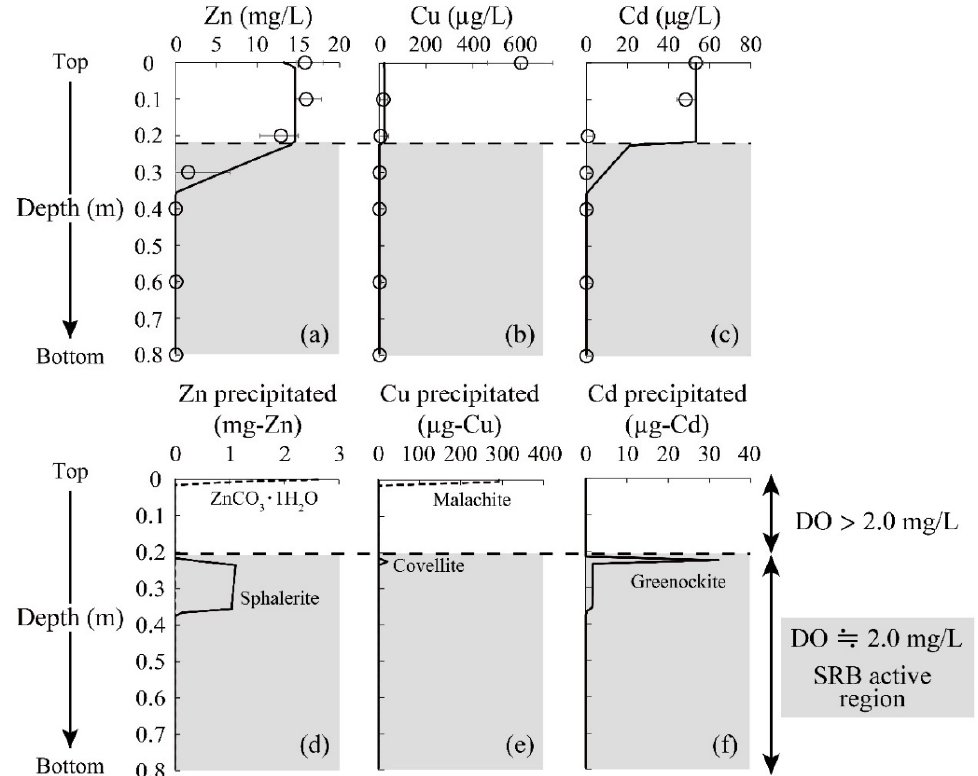
Figure 4. Changes in the heavy metal concentrations (plots) and geochemical model fitting (solid line) as a function of column depth ( a – c ). Error bars depict the average values of the duplicate test. Estimated precipitates by model calculation are also shown ( d – f ).